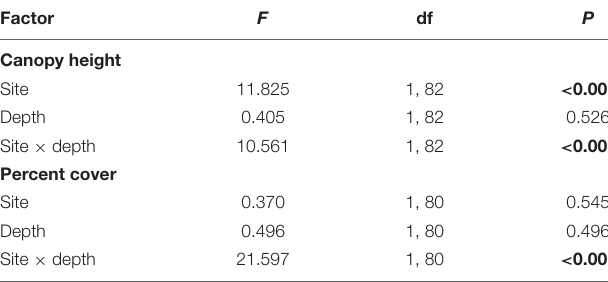
Significant terms are highlighted in bold (p <